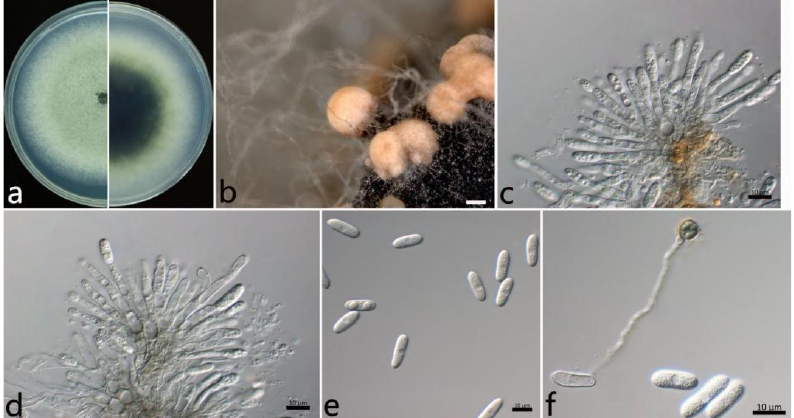
Figure 5. The morphological characteristics of Colletotrichum gloeosporioides s.s. (NL1-7) isolated from anthracnose leaves of Salix babylonica . ( a ) Colony on PDA from above and below (5 d). ( b ) Conidial masses (on PDA). ( c , d ) Conidiophores, conidiogenous cells, and conidia. ( e ) Conidia. ( f ) Conidia and appressorium. Scale bars: ( b ) = 500 µm; ( c , f ) = 10 µm. 2.3.4. Colletotrichum siamense Prihastuti, L. Cai and K. D. Hyde (Figure 6) The colonies on PDA were white to grayish white at the center. The aerial mycelium was abundant and cottony. Orange conidial masses were in the center of the colonies. The colony growth rate on PDA was 14.8 mm/d. The acervuli were orange, spherical or ellip- tical, numerous, and pale to dark grey at the base. The setae were dark brown, with two to three septates, thick-walled, straight, in groups, tapering toward the apices, and (85.4– ) 75.9–111.1 (–117.6) µm (mean ± SD = 93.5 ± 17.6 µm ( n = 30)). The conidiophores were hyaline to pale brown, septate, and branched. The conidiogenous cells were phialidic, hy- aline, thin-walled, smooth, (9.6–) 10.8–17.4 (–20.0) × (2.3–) 2.9–3.9 (–4.6) µm (mean ± SD = 14.1 ± 3.3 × 3.4 ± 0.5 µm ( n = 50)), and with an L/W ratio = 4.2. The conidia were one-celled, straight, subcylindrical, hyaline with a rounded end, (11.5–) 13.8–15.8 (–16.5) × (5.4–) 6.2– 7.0 (–7.5) µm (mean ± SD = 14.8 ± 1.0 × 6.6 ± 0.4 µm ( n = 50)), and with an L/W ratio = 2.3. The appressoria were one-celled, ovoid or ellipsoidal, brown or dark brown, smooth, (6.7– ) 7.1–8.7 (–10.1) × (5.3–) 5.9–6.7 (–7.1) µm (mean ± SD = 7.9 ± 0.8 × 6.3 ± 0.4 µm ( n = 50)), and with an L/W ratio = 1.3. The specimens examined were as follows: China, Jiangsu Province: Suzhou City, 31°20′34″ N, 120°35′18″ E, on the leaves of Salix babylonica , June 2021, Mengyu Zhang, cul- tures YH2-2, YH2-3, YH2-5, and YH2-6; Nanjing City, 32°5′10″ N, 118°49′13″ E, and 32°3′2″ N, 118°50′26″ E, on the leaves of S. babylonica , October 2021, Mengyu Zhang, cultures NL1- 10, NL1-13, MXL1-1, and MXL1-10; and China, Hubei Province: Wuhan City, 30°43′10″ N, 114°31′59″ E, on the leaves of S. babylonica , October 2021, Mengyu Zhang, culture WH2-7. Notes: The ITS, CHS , and TUB sequences do not separate C. siamense from C. fructi- cola . However, these species are best distinguished using CAL sequencing and a multi- locus analysis. Colletotrichum siamense was first reported on the berries of Coffea arabica in Thailand [44]. Most previous studies have had difficulties distinguishing among C. sia- mense , C. jasmini-sambac , and C. hymenocallidis within the C. gloeosporioides complex [45,46]. However, later on, C. jasmini-sambac and C. hymenocallidis were demoted as synonyms of C. siamense [22].